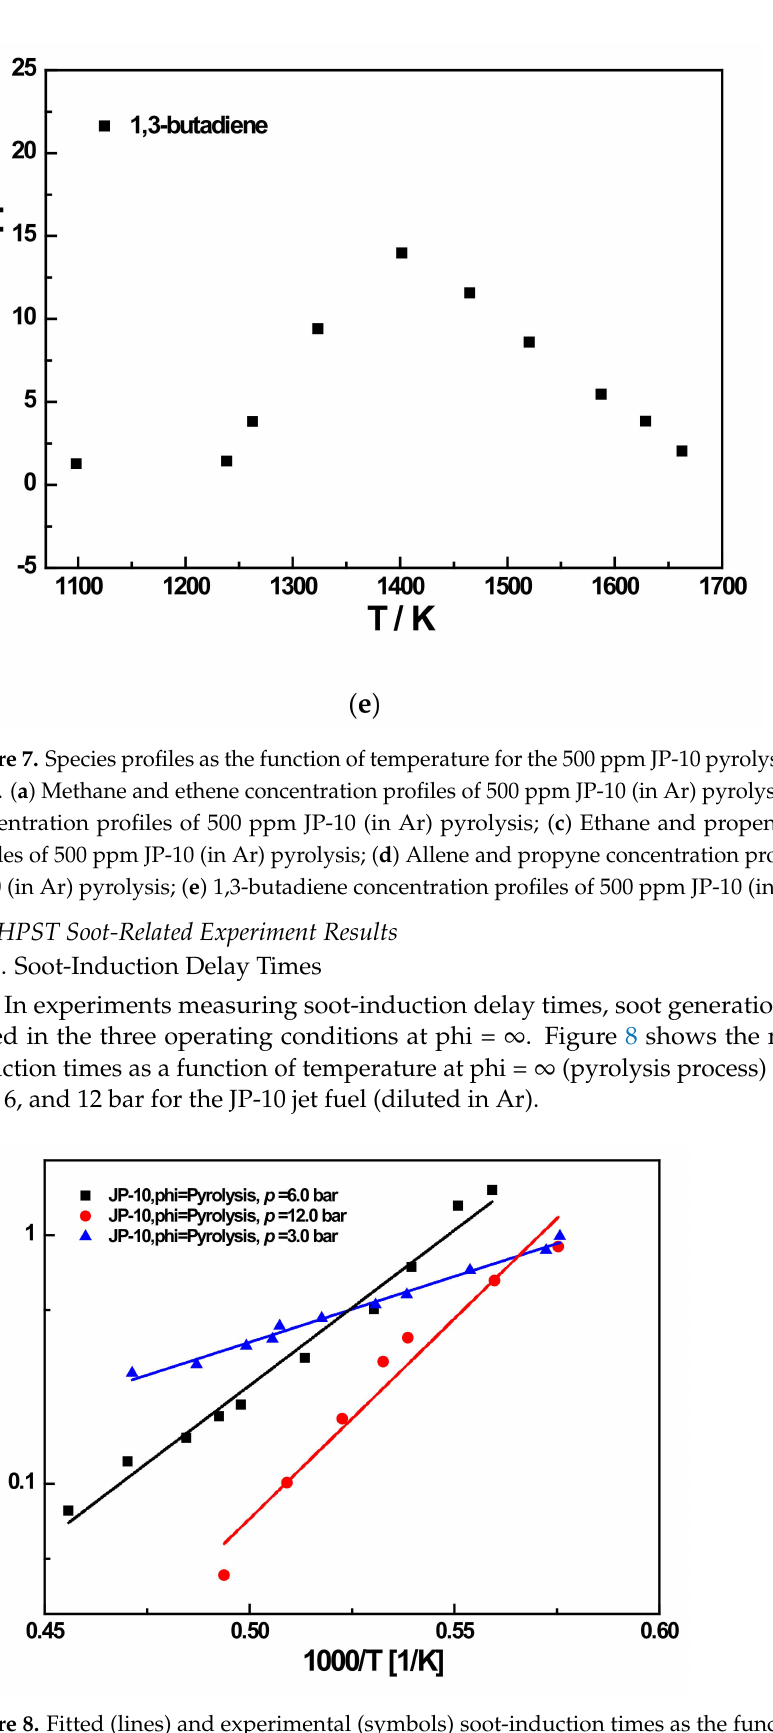
Figure 8. Fitted (lines) and experimental (symbols) soot-induction times as the function of tempera- ture for the